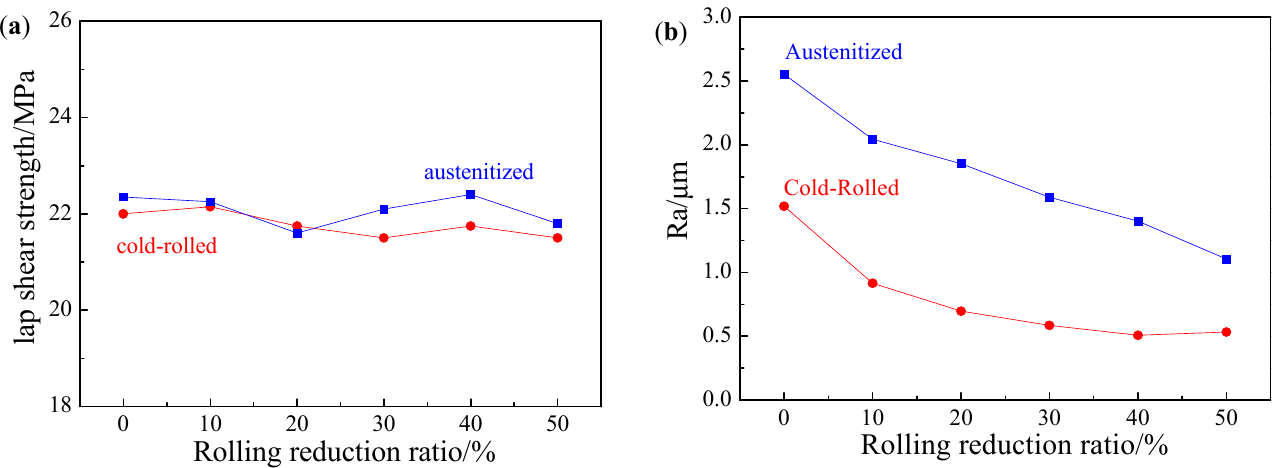
Figure 9. ( a ) Lap shear strength of AS60/60 coating at different reduction ratios; ( b ) surface roughness (Ra) of AS60/60 coating at different reduction ratios.